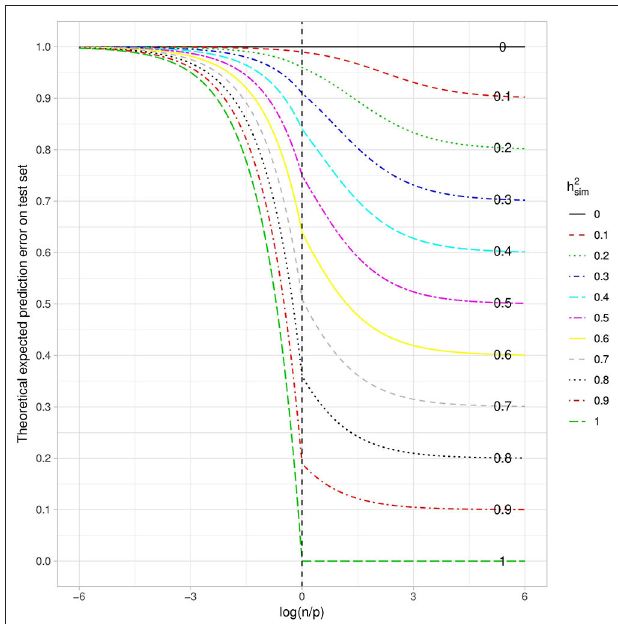
FIGURE 2 | Theoretical Quadratic Error with respect to the log ratio of the number of individuals over the number of variants in the training set. Each curve corresponds to a given heritability (in the narrow sense). Note that the total variance is assumed to be